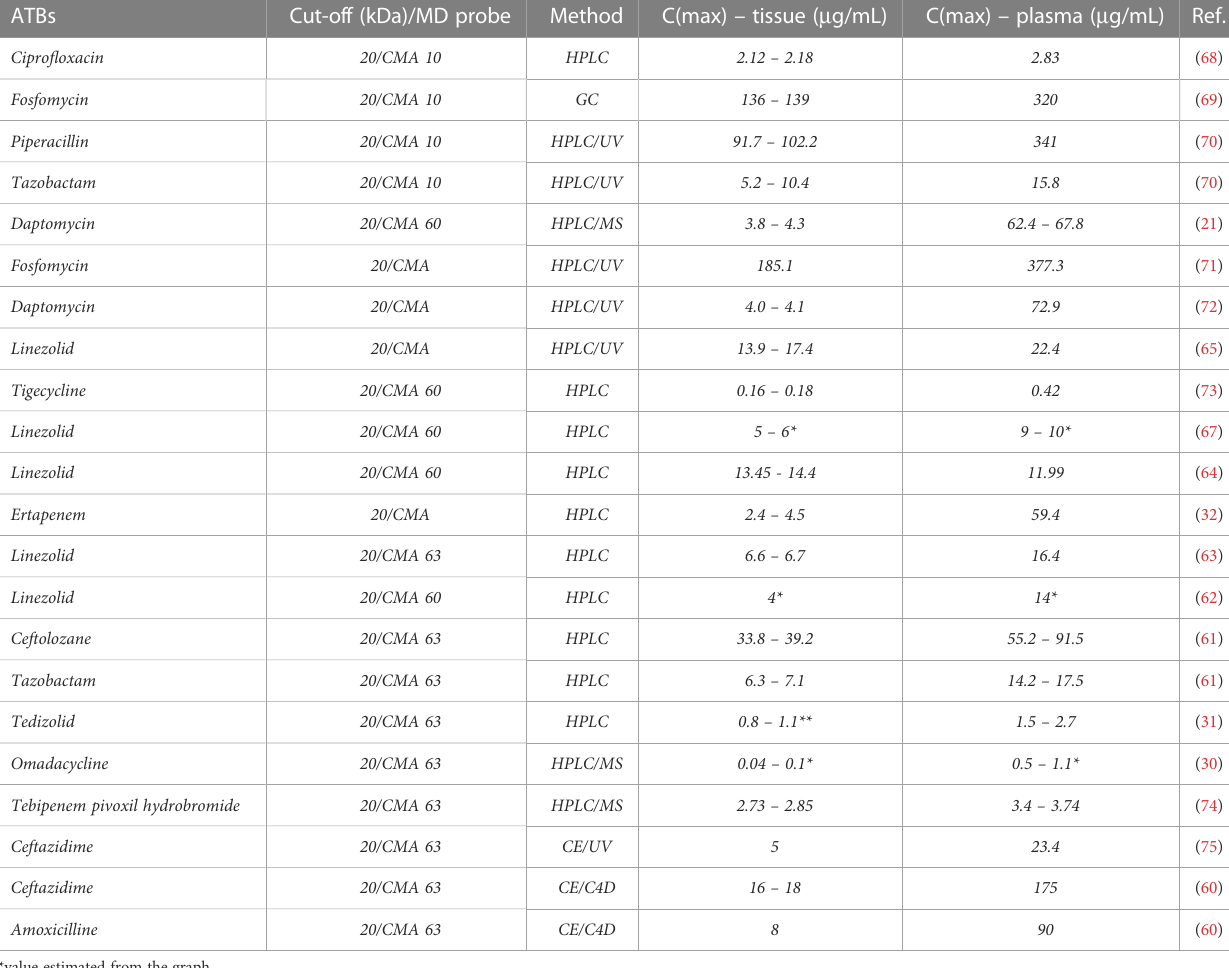
TABLE 1 A summary of peripheral tissue sampling using microdialysis techniques to detect ATB levels in the diabetic foot. ATBs Cut-off (kDa)/MD